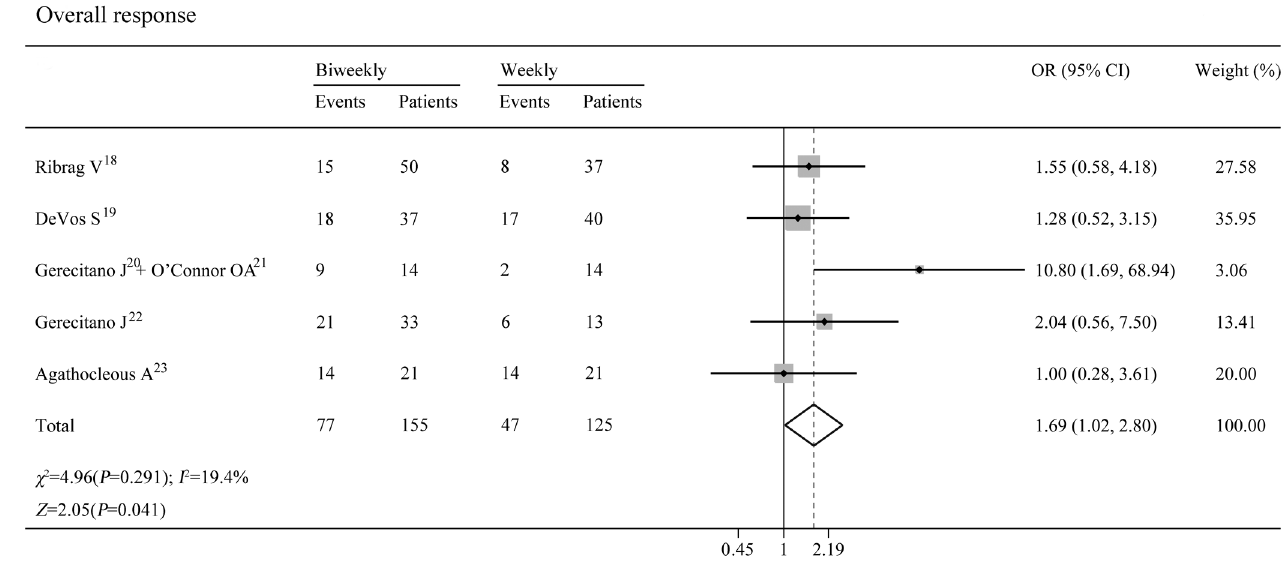
Fig 2. Pooled analysesof overall